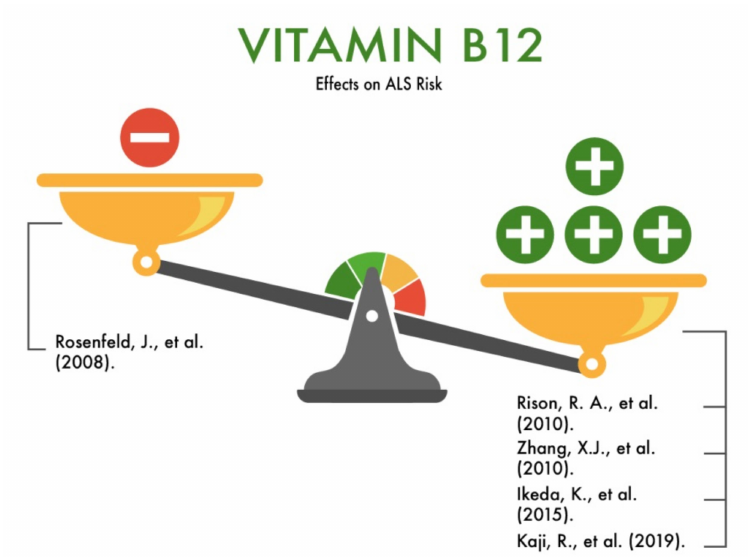
Figure 7. The effect of vitamin B12 on the risk of developing amyotrophic lateral sclerosis